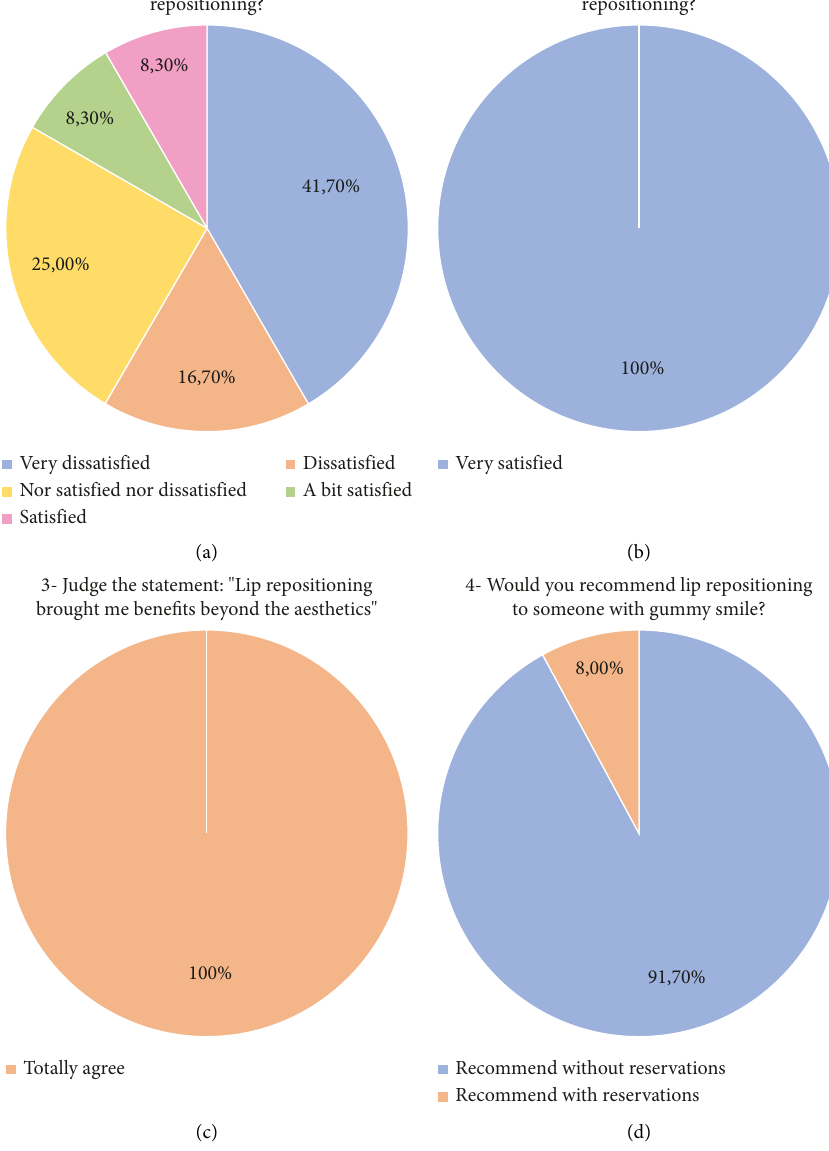
Figure 10: Answer of the question carried out for the evaluation of patient satisfaction, serving as an auxiliary analysis instrument. (a) Satisfaction graph of patients before the surgery. (b) Satisfaction graph of patients after the surgery. (c) Satisfaction graph of patients with the new condition reached. (d) Graph of recommendation degree of lip repositioning to someone